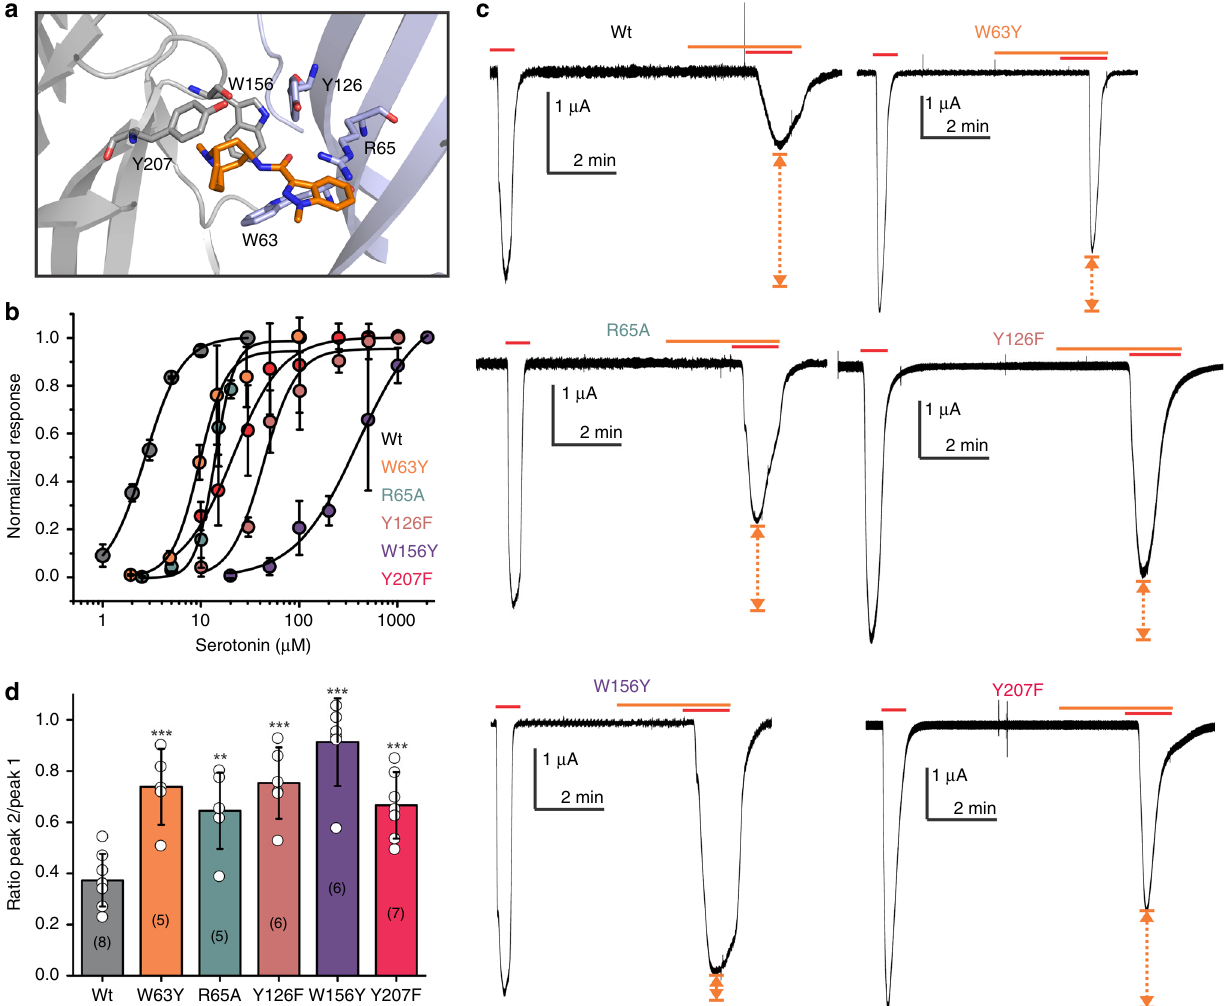
Fig. 5 Effects of mutations at the ligand-binding pocket on granisetron inhibition. a Granisetron interactions with Trp156 and Tyr207 from the principal subunit and Trp63, Arg65, Tyr126 from the complementary subunit are depicted as stick representation. b Serotonin dose response measured by two- electrode voltage clamp (TEVC) recordings (at − 60mV) for wild-type (WT) 5-HT 3A R, W63Y, R65A, Y126F, W156Y, and Y207F mutants, expressed in oocytes. The half-maximal effective concentration (EC 50 ), the Hill coef fi cient (nH), and the number of independent oocyte experiments for WT and mutants are: WT (EC 50 : 2.70 + 0.09 μ M; nH: 2.3 + 0.17; n: 3), W63Y (EC 50 : 9.93 + 0.77 μ M; nH: 3.1 + 0.72; n: 4), R65A (EC 50 : 13.79 + 0.50 μ M;